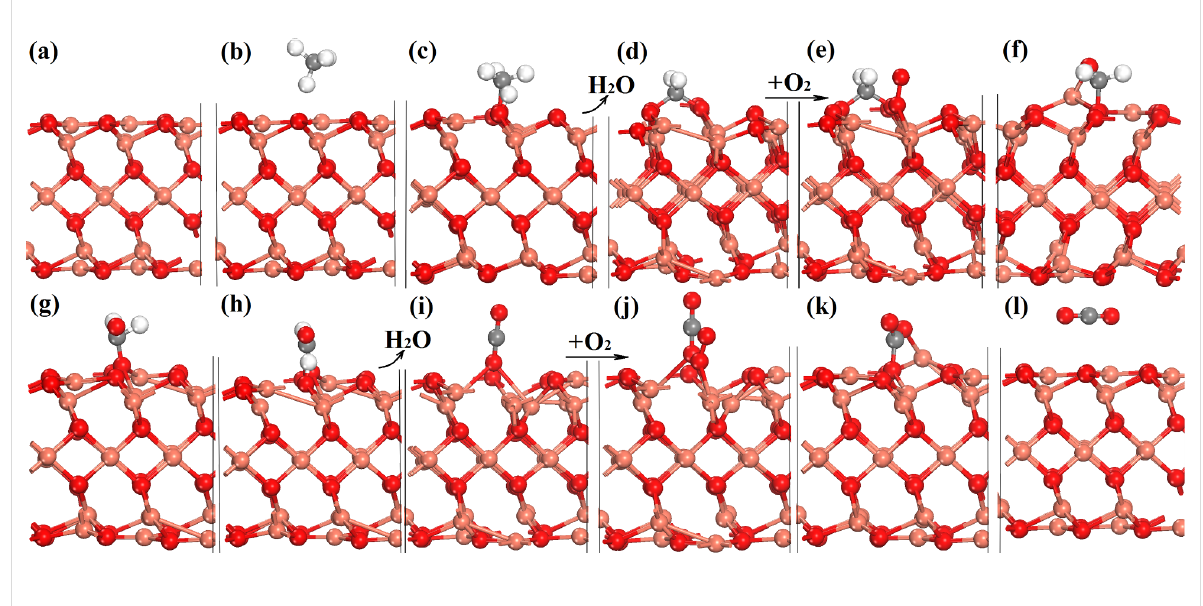
Figure 4: CH 4 oxidation mechanism by computational calculations. (a) Clean (001); (b) CH 4 physical adsorption; (c) CH 4 dissociative adsorption; (d) CH 2 * with oxygen vacancy (OV) presented; (e) CH 2 * with O 2 adsorbed; (f) CH 2 * rotating and interacting with O 2 *; (g) transition state (TS) state COH 2 *; (h) CHO* + H*; (i) CO* with OV presented after releasing one H 2 O; (j) CO* with O 2 adsorbed; (k) TS for O transfer to CO*; (l) CO 2 physical adsorbed. Cu, O, C and H are shown as rose-carmine, red, grey and white spheres, respectively.